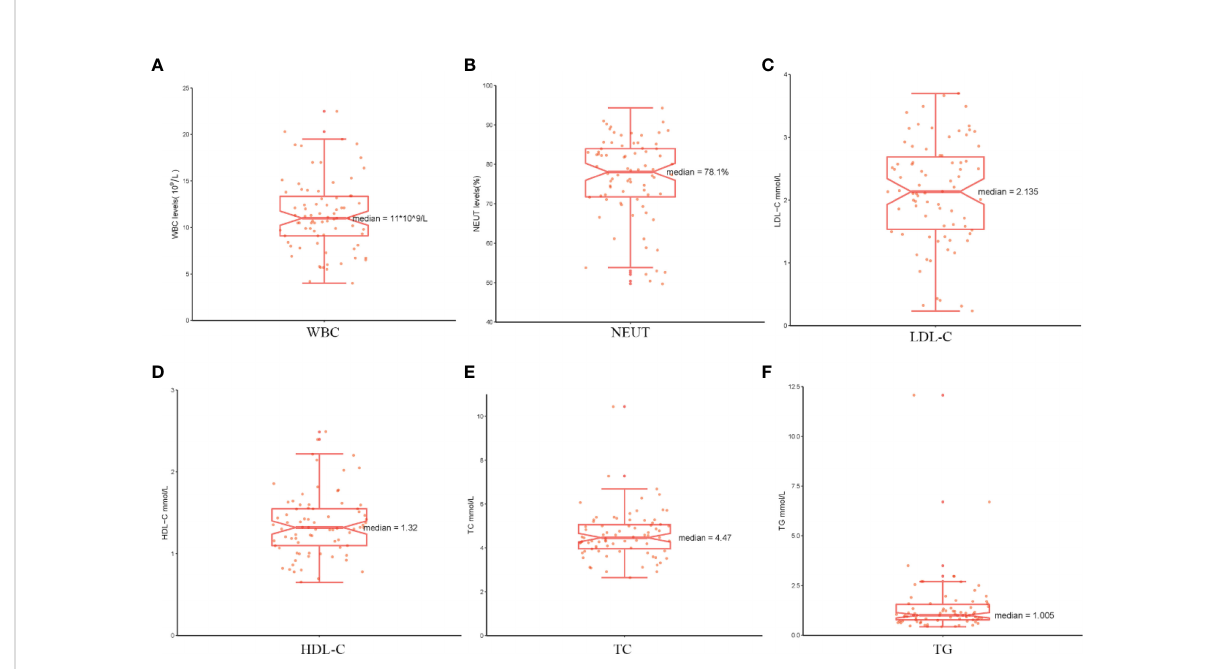
FIGURE 8 The serum markers analysis in patients with AD. (A – F) The serum levels of WBC, NEUT%, LDL-C, HDL-C, TC and TG are shown separately using box